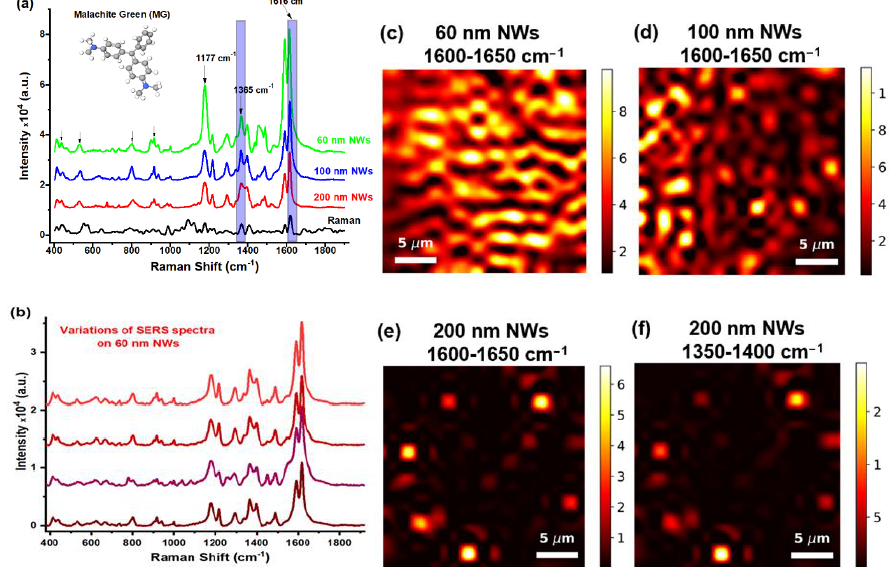
Figure 5. ( a ) Raman spectrum of 0.27 mM MG solution multiplied by 10, then SERS spectra of 0.27 µM MG solution on substrates with NWs with a diameter 200 nm, 100 nm and 60 nm. ( b ) SERS spectra recorded from different parts of the substrate with 60 nm diameter NWs. ( c – e ) SERS-mapping of substrates with NWs with a diameter of 60, 100, and 200 nm, which was plotted from the area under the peak located at 1616 cm −1 . ( f ) SERS-mapping of substrates with an NW of diameter 200 nm, which was plotted from the area under the peak located at 1365 cm −1 . Figure 5c – e shows the SERS-mapping of 60, 100, and 200 nm-diameter NW sub- strates, which was plotted by the area under the peak located at 1616 cm −1 , since this is one of the strongest peaks. It is clearly seen that substrates with an NW diameter of 60 nm are the most efficient due to the formation of NW agglomerates in the form of a cellular structure. At the same time, NWs with a diameter of 200 nm are the least effective since there are very few areas where such NWs lean together, in addition to hot spots. It should be especially noted that there is no variation in the position of SERS peaks, which is demonstrated by a set of spectra of MG adsorbed on NWs with a diameter of 60 nm at different amplifying parts of the substrate (Figure 5b). This directly indicates the stability of the SERS signal amplification and characterizes the enhancing stability of the substrate. This is likely due to the feature of the technique for fabricating SERS-active sub- strates by the template synthesis method, which provides a high level of reproducibility of the substrate structure over a large area. The set of vibrational modes of the MG dye is small, and if the molecule hits the amplifying surface, then all peaks will be uniformly enhanced. This is demonstrated by the SERS-mapping of MG molecules on the substrate with 200 nm diameter NWs (Figure 1e,f). The enhancing regions are located in the same parts for three different characteristic MG peaks. Summing up the case of relatively “small” organic molecules (exemplified by MG), it can be stated that the SERS spectra obtained from different parts of the SERS substrate are qualitatively the same, but fluctuations of intensity (i.e., enhancement coefficient) can be strong. The level of fluctuations depends on the nanostructure of the SERS surface and decreases with decreasing diameter of NWs. The most homogeneous map was observed for 60 nm NWs but, even in this case, obtaining a robust, reproducible and recognizable Raman fingerprint requires the mapping of the SERS substrate to find obvious hot spots. It is especially important for single-molecule concentrations of the analyte.